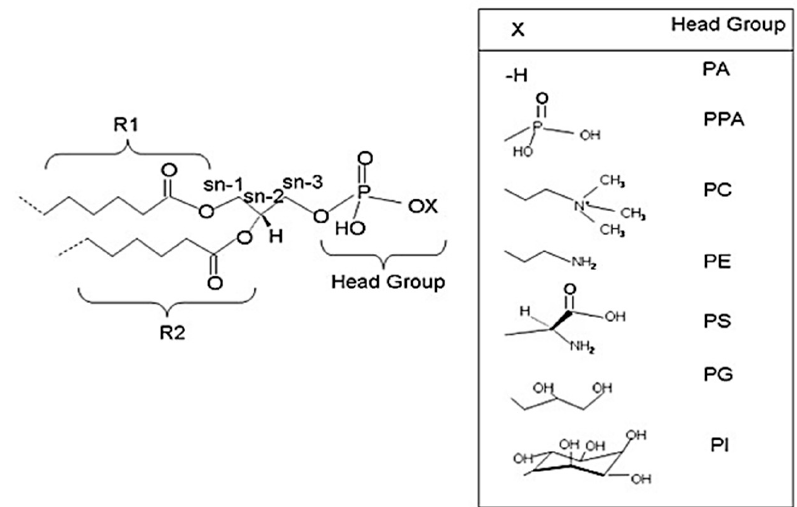
Figure 1. Structures of glycerophospholipids (GPs). R1, R2, and X are variables at sn-1 , sn-2 , and sn-3 positions, respectively. Depending on the head group at sn-3 position, several GPs are formed. PA: phosphate; PPA: pyrophosphate; PE: phosphatidylethanolamine; PC: phosphatidylcholine; PS: phosphatidylserine; PG: phosphoglycerol; PI: phosphoinositol [10]. (Copyright © 2022, Yetukuri et al.; licensee BioMed Central Ltd., London, UK).